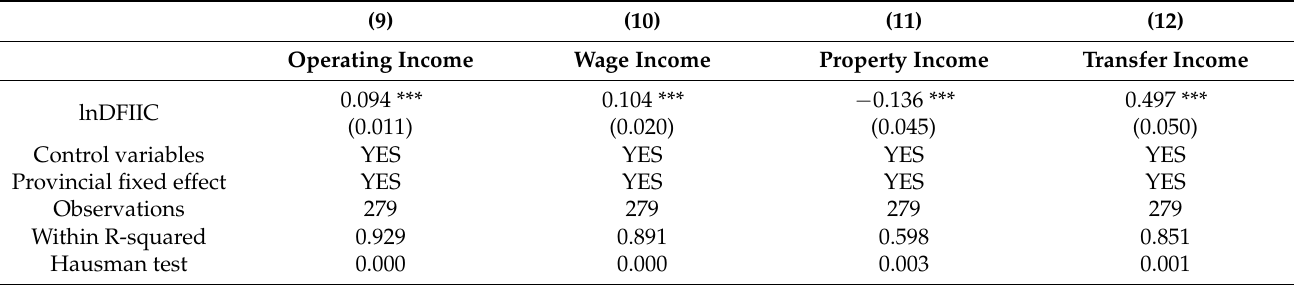
Table 4. Digital inclusive finance and rural resident income structure.